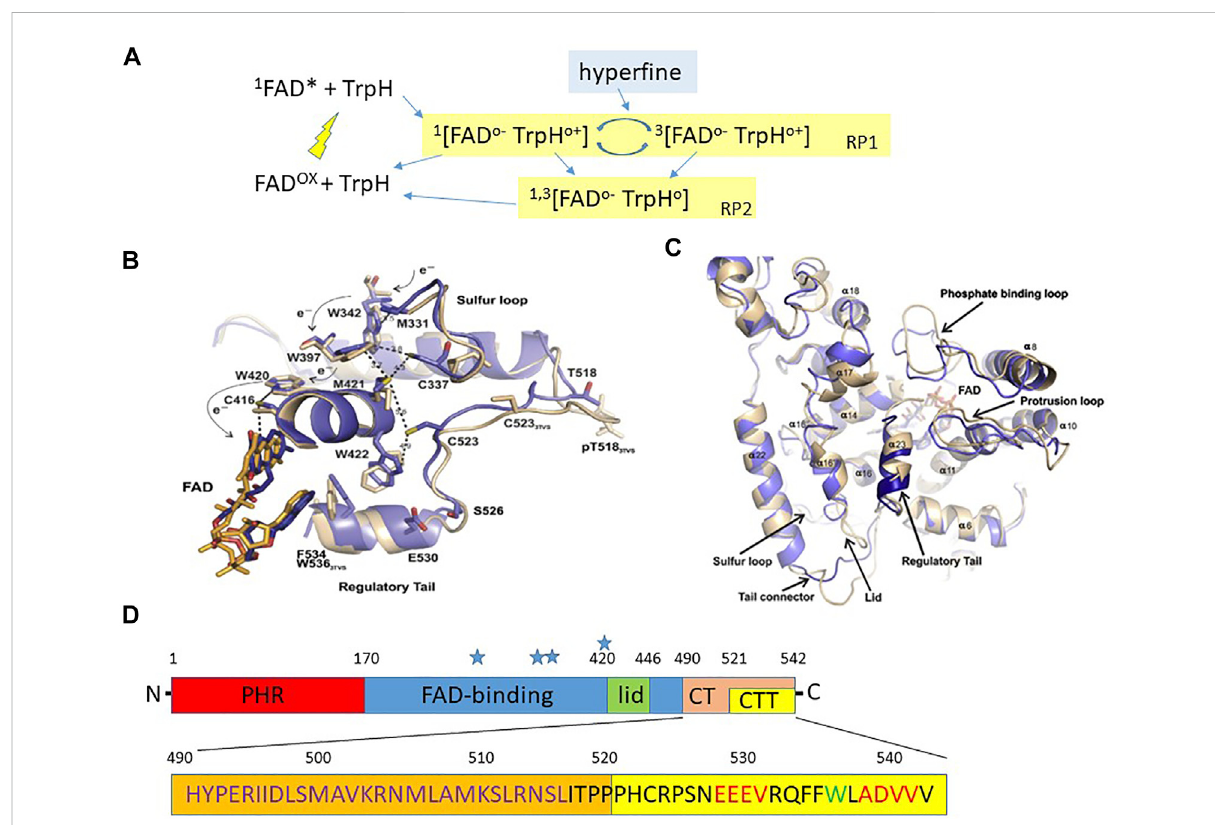
FIGURE 1 Structure of Drosophila cryptochrome. (A) The framework for a CRY photocycle using Escherischia coli photolyase ( Ec PL) and Arabidopsis thaliana CRY1 ( At CRY1). Photoexcitation excites the oxidised FAD (FAD ox ) to the singlet state ( 1 FAD*) which then receives an electron via a chain of three Trp residues (see Figure 1B) within CRY/photolyase generating a radical pair leaving the terminal Trp minus an electron 1 [FAD o − TrpH o+ ] in the singlet state with antiparallel electron spins which can either reverse to the ground state (FAD ox + TrpH) or interconvert to the triplet state 3 [FAD o − TrpH o+ ] via hyper fi neinteractionsinwhichtheelectronspinsoftheunpairedelectronsareinparallel.In Ec PLtheSandTformsofthisRP(RP1) can also convert to a second RP2 by deprotonation (removing H ion) of TrpH o+ to the neutral radical, Trp o which can return to the dark resting state (FAD ox + TrpH)byfurtherredoxreactions (redrawn withamendmentsfrom Sheppard etal.,2017). (B) Crystalstructureof d CRYregions lyingcloseto theFAD(blue fromCzarnaetal., 2013, beigeZoltowskietal., 2011).TheTrptriad W420, 397and342are showntogetherwith theproposedelectron skipping that generates the photoreduced FAD-Trp radical pair. (C) Crystal structure of d CRY from Czarna et al (2013). The blue represent the structure from Czarna et al. compared to a previous structure in beige from Zoltowski et al (2011). There are some signi fi cant differences in the tail structure, later correctedby Zoltowski et al (2011). (B,C) reproduced with permission from Czarna et al. (2013). (D) Overview of d CRY landmarks (not to scale).PHR, Photolyase homology domain; CT, C terminal residues 490 – 542; CTT C terminal tail, residues 520 – 542; Blue stars indicate positions ofTrptetrad, Trp342,394,397and420.TheaminoacidsequenceoftheCTisillustratedbelow. Thecalmodulinbindingdomain isshown inorange, residues ~490 – 516 in violet. PDZ domain binding motifs in the CTT are in red, and the sole Trp in the CTT is green. The dCRY Δ transgene is missing the CRY CTT and the GFP-CRY CT transgene encodes GFP fused to residues 490 – 542 (see